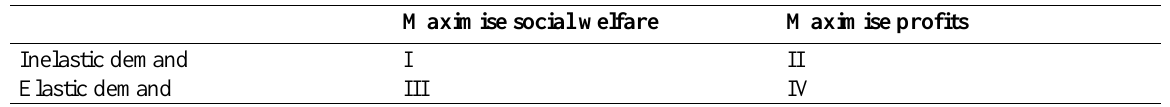
Table 1. Four choice contexts of frequency and vehicle size by public transport